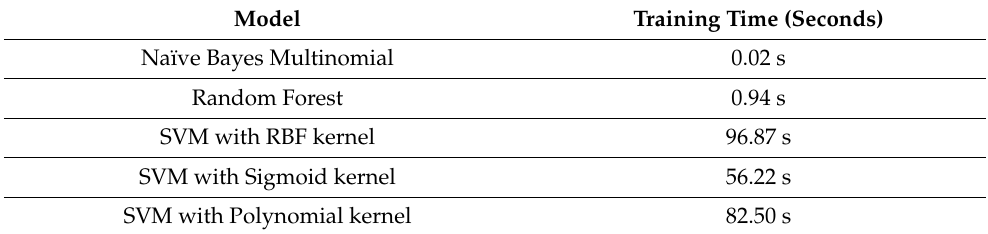
Table 1. Time required to build ML models.